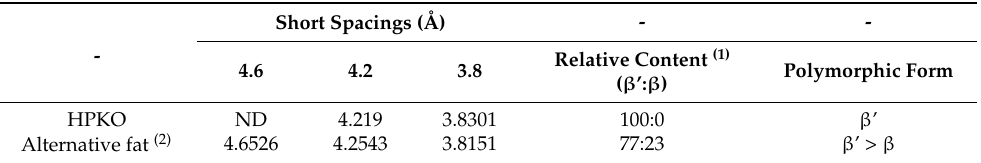
Table 4. Polymorphic crystal form and short spacings (Å) of hydrogenated palm kernel oil (HPKO) and alternative